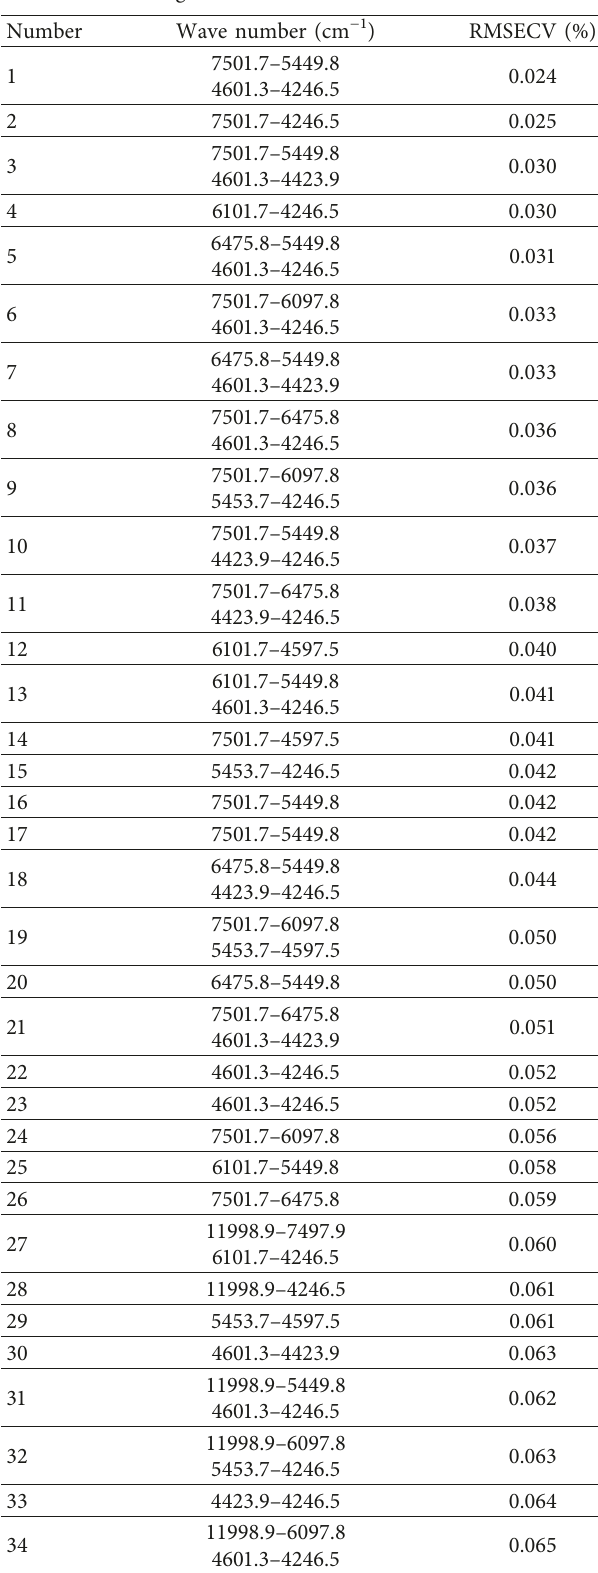
Table 4: The relationship between spectral wave number and RMSECV for